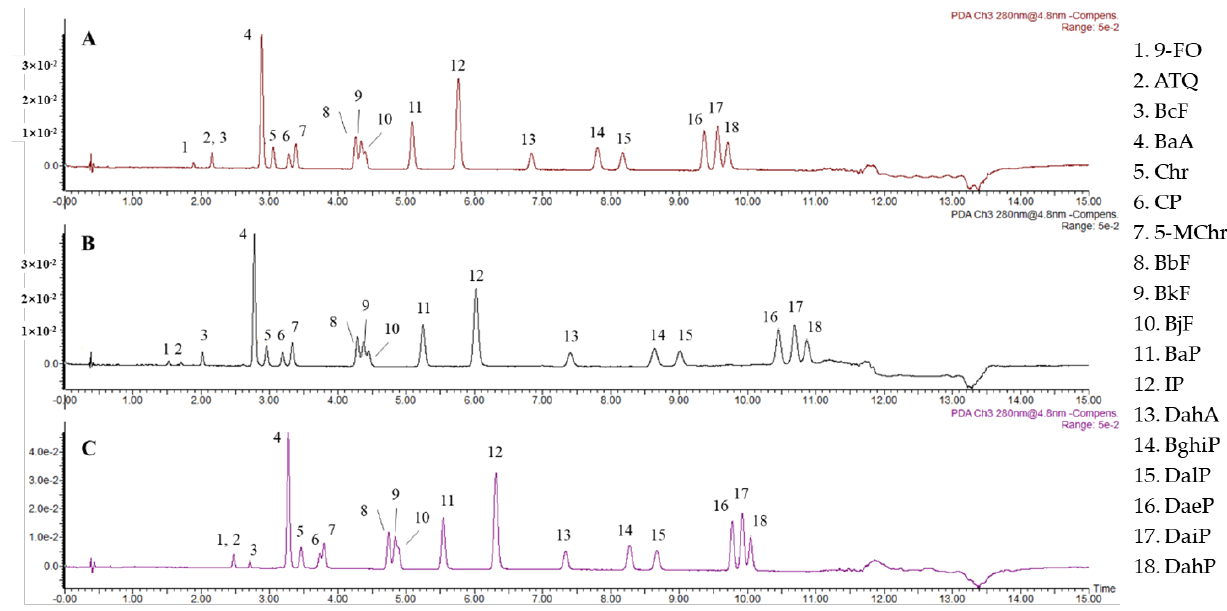
Figure 1. SFC chromatography of 18 PAHs in different mobile phases (1000 μg/kg). ( A ) Methanol/acetonitrile (1:1, v/v ), ( B ) methanol, and ( C ) acetonitrile (0.5% formic acid), and 1–18 peaks represent 9-FO, ATQ, BcF, BaA, Chr, CP, 5-MChr, BbF, BkF, BjF, BaP, IP, DahA, BghiP, DalP, DaeP, DaiP, and DahP, respectively.